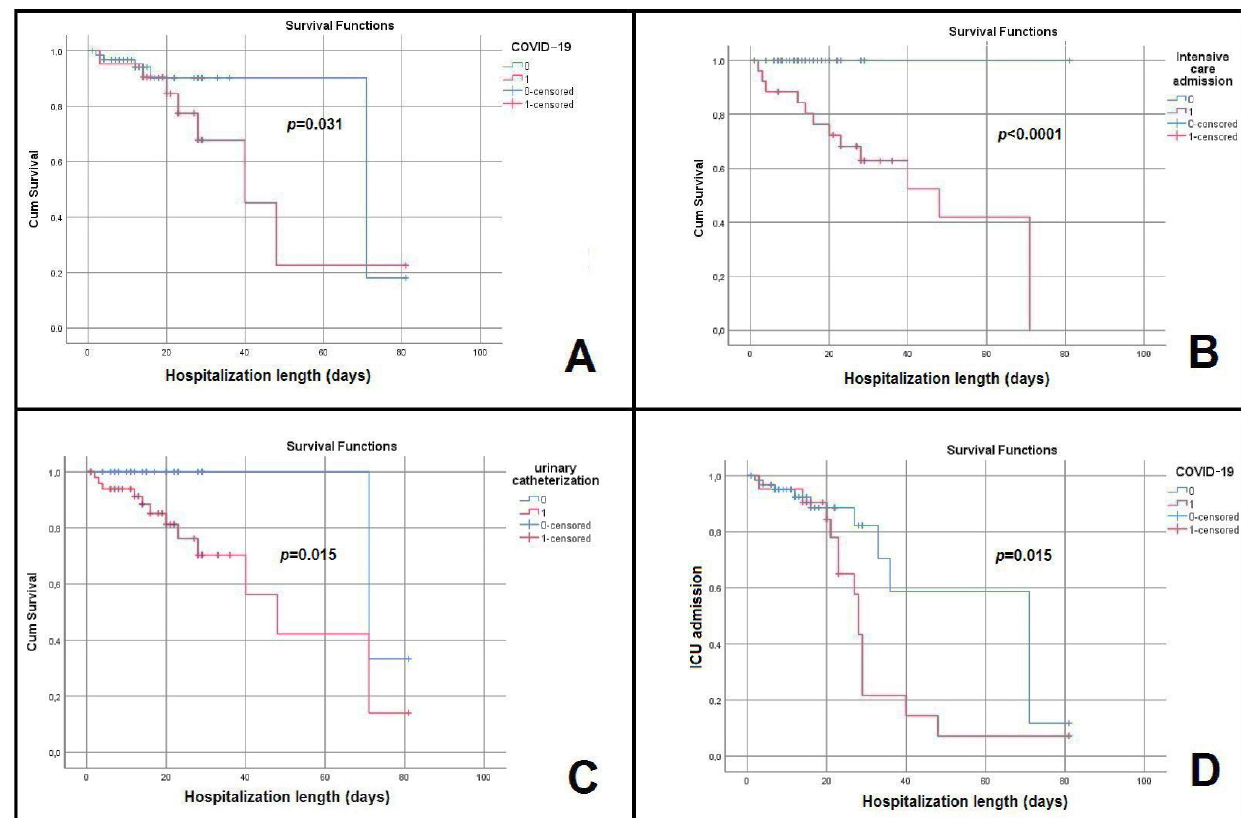
Figure 3. Cumulative proportions of mortality estimates ( A )—between patients with (red line) and without (blue line) COVID − 19; ( B )—between patients admitted (red line) or not (blue line) in the ICU setting; ( C )—between patients that were urinary catheterized (red line) or not (blue line). ( D )—Cumulative proportions of ICU admission estimates between patients with (red line) and without (blue line) COVID − 19.